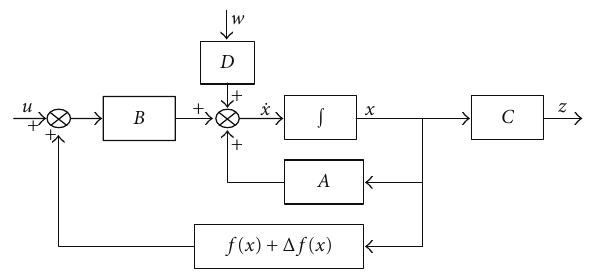
Figure 1: The block diagram of the system